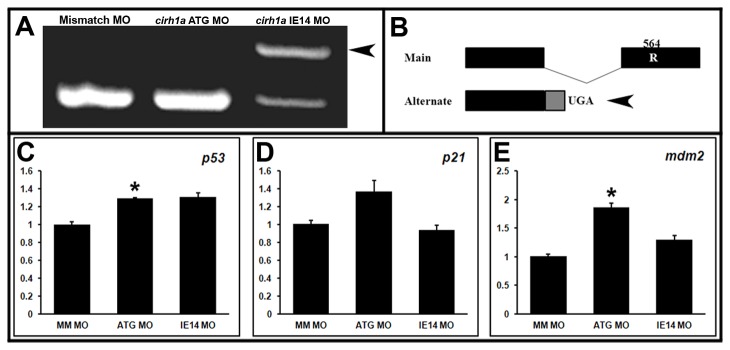
Activation of p53 pathway in Cirhin-deficient larvae.(A) RT-PCR with primers directed at cirh1a exons 13-15, demonstrating altered mRNA splicing following injection of IE14 MO (arrowhead). (B) Schematic of cirh1a alternative splicing due to IE14 MO, with alternate inclusion of intron 14 creating an in-frame stop codon. (C-E) Quantitative RT-PCR for tp53 (C) and p53 targets p21 (D) and mdm2 (E), expressed as fold increase over control mismatch MO-injected larvae. *, p<0.05 vs Mismatch MO 1 ng.